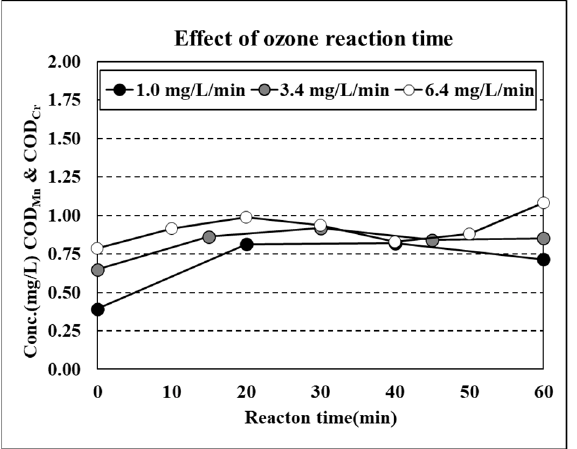
Figure 6. Ozone dosage and reaction time effects .